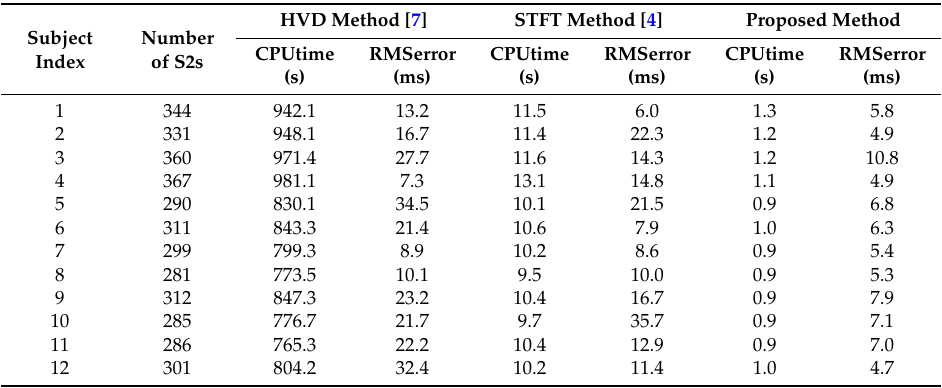
Table 3. Comparison of CPU time and RMS error among the three